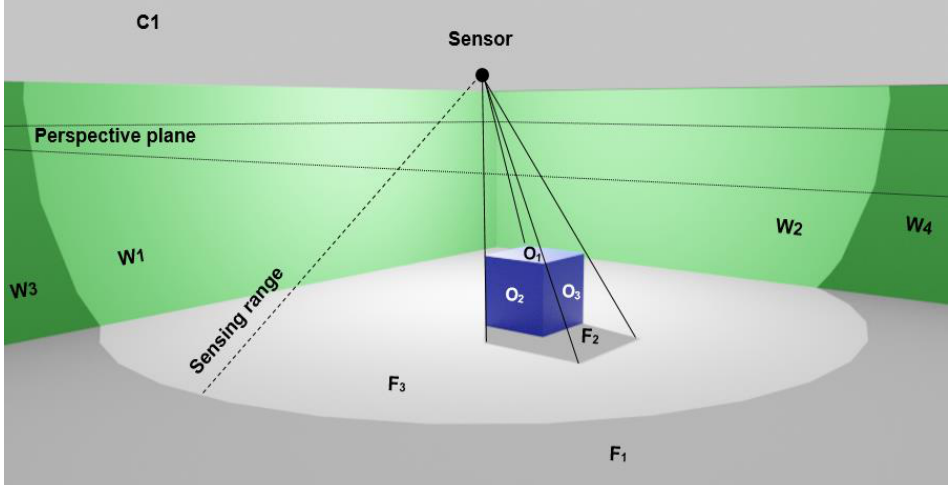
Figure 6. Coverage estimation based on overlapping visible surfaces projected onto the perspective plane. Surface F 1 is out of whole area of sensing distance, and surface F 2 is hidden by surface O 1 .